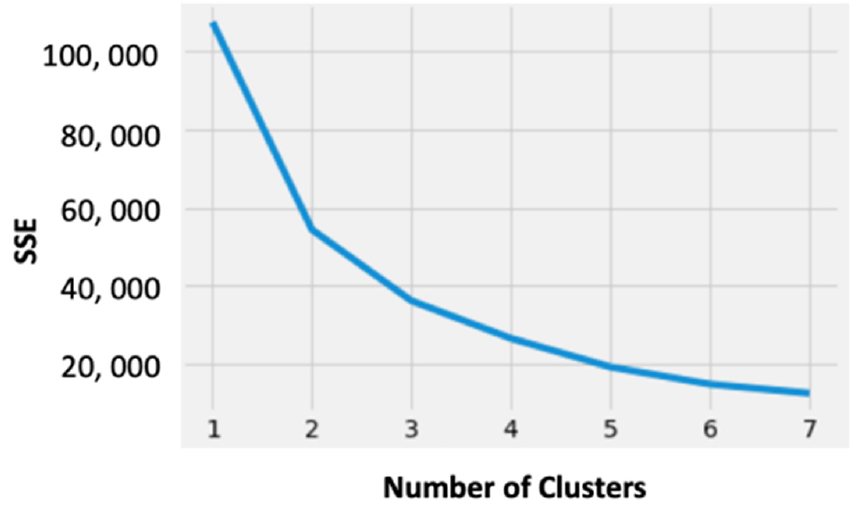
Figure 5. Elbow method for detecting the number of clusters.